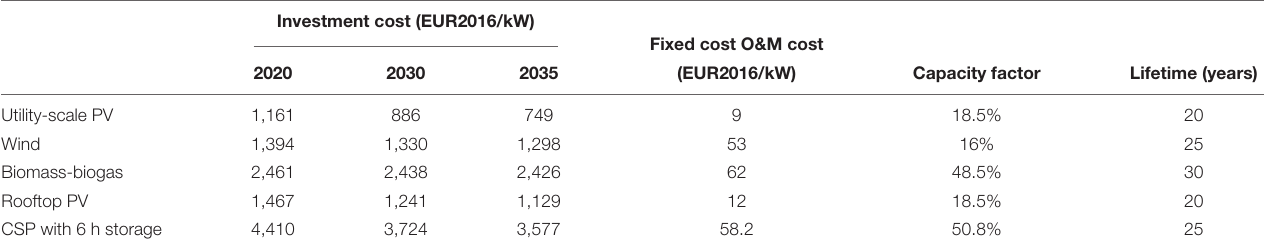
TABLE 2 | Techno-economic assumptions of renewable energy technologies for